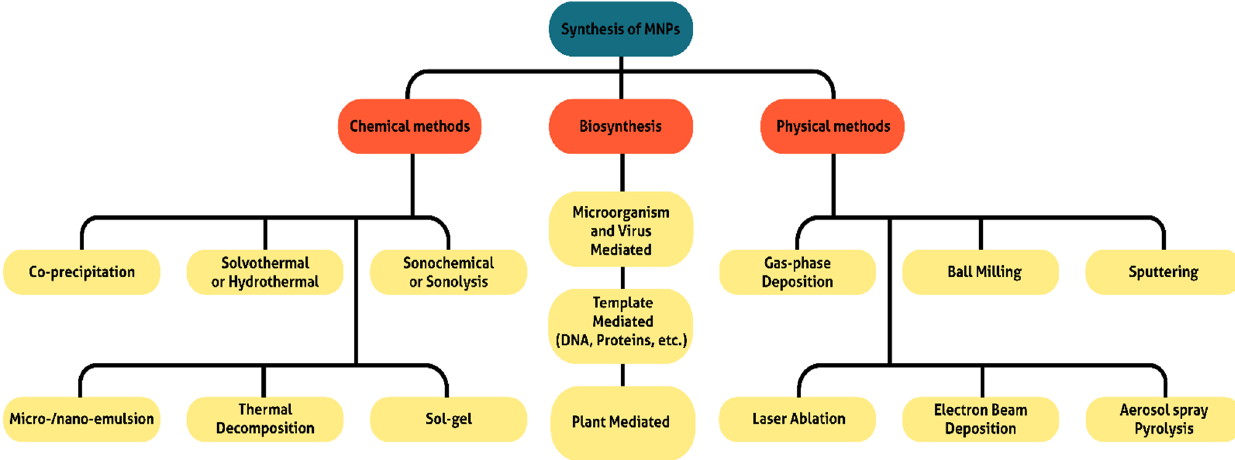
Figure 3. Primary MNP synthesis methods.